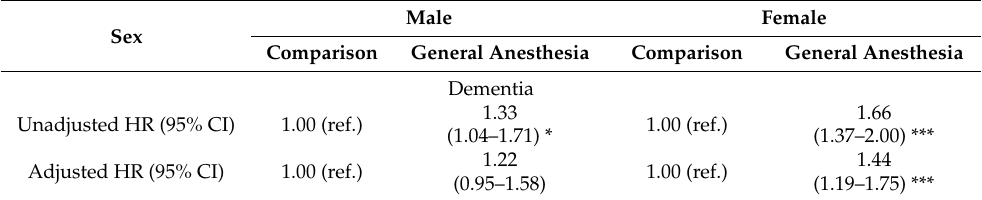
Table 3. Hazard ratios of dementia by sex among the patients.